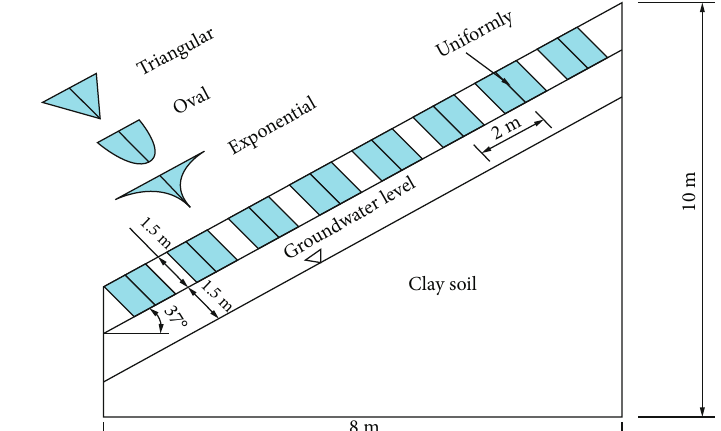
Figure 3: Geometric model of the slope.